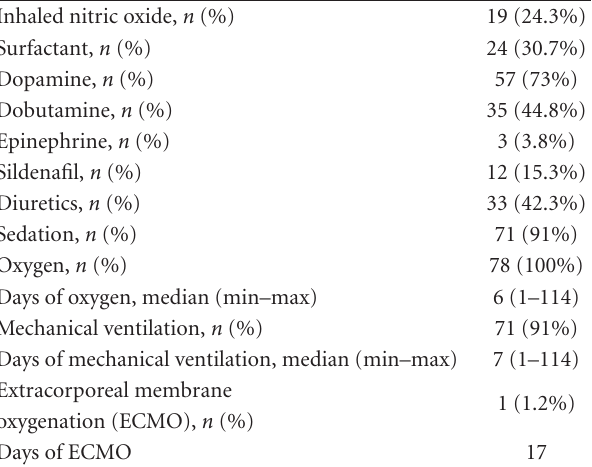
Table 3: Treatment ( n =